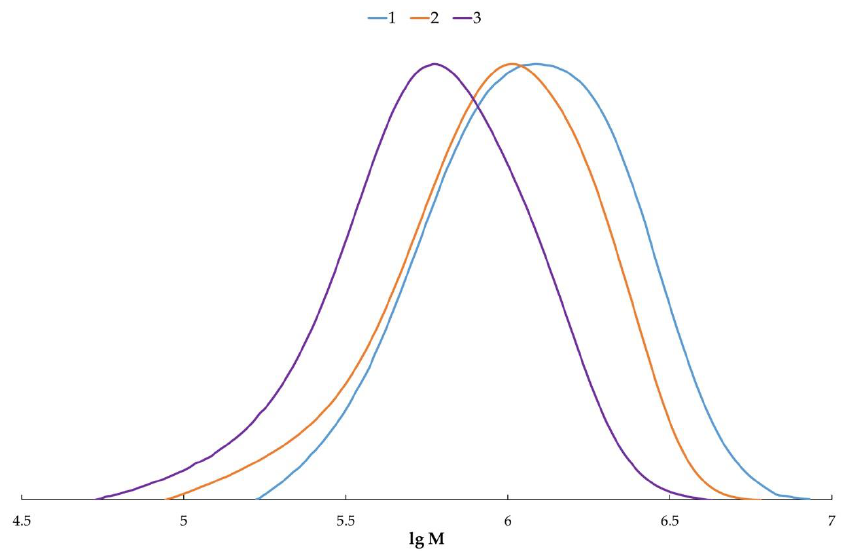
Figure 4. MWD curves of PMMA isolated by enzymatic hydrolysis from Gel-PMMA copolymers synthesized in the presence of ( 1 ) AIBN, TBB, and 2,5-DTBQ; ( 2 ) AIBN and TBB; ( 3 ) TBB and 2,5-DTBQ.